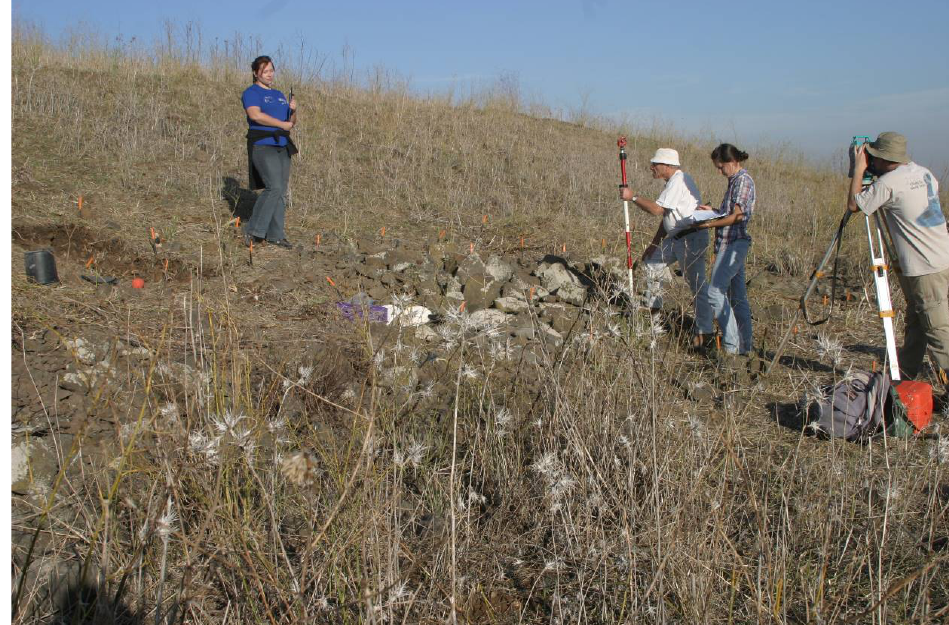
Figure 2. A view over the southern slope of the site.